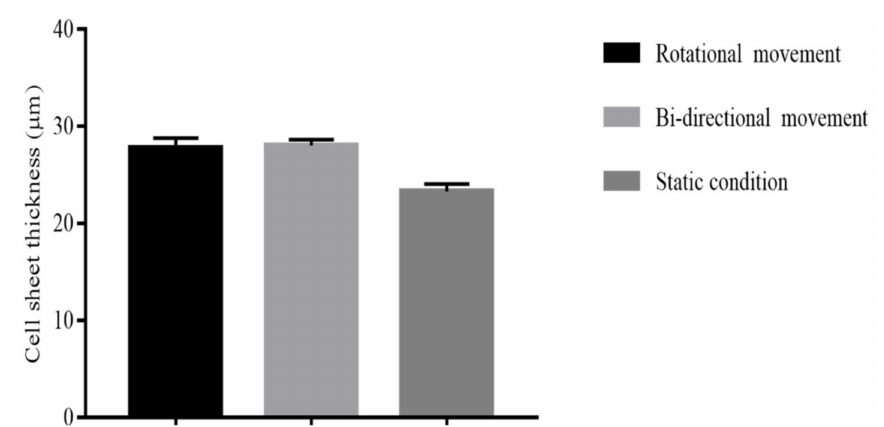
Figure 5. Thickness measurement of produced ASC-based self-assembled scaffold using rotational, bidirectional and static culture conditions. The graph shows mean measurements ± SEM. The reading of thickness measurement for each of the self-assembled scaffolds was repeated in five predetermined positions (technical replicate). The results are representative of measurements from three biologically independent samples. * Represents statistically significant difference using paired t test ( p <